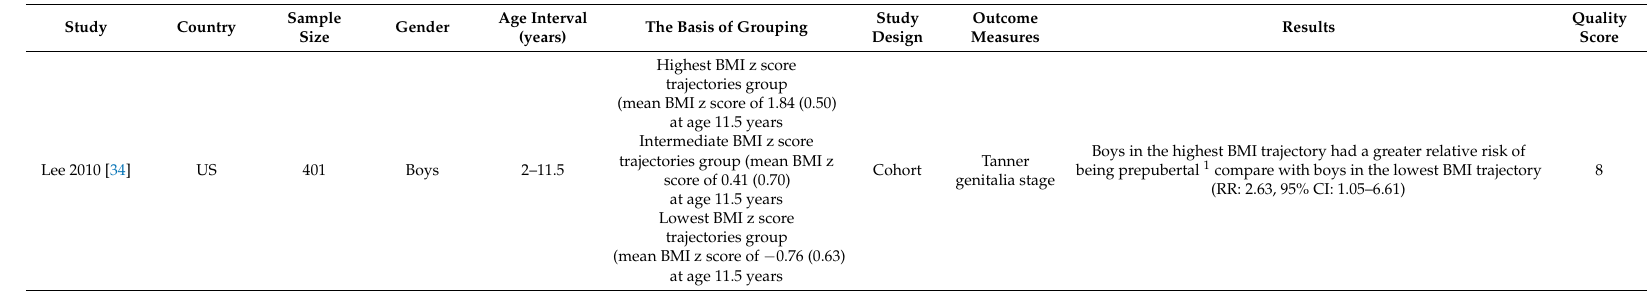
Table 2. Characteristics of studies included in the systematic review but not in